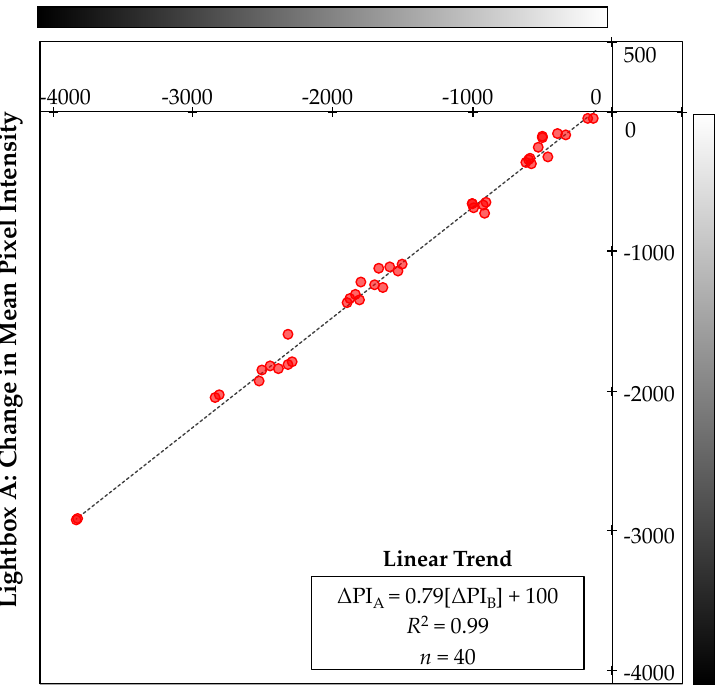
Figure A7. Correlation of change in reflectance of samplers ( n = 40) after 258 days of exposure in 20 indoor field locations, as estimated using two di ff erent lightboxes: lightbox used for field testing (Lightbox A in Hyderabad, India; Figure A2c,d) and lightbox used for laboratory testing (Lightbox B in Seattle, WA, USA; Figure A2a,b). Change in reflectance (measured by change in mean pixel intensity (PI; unitless) and illustrated by grayscale) ranges from 0 (indicating no change in grayscale) to − 4095 (indicating a change from perfect white to perfect